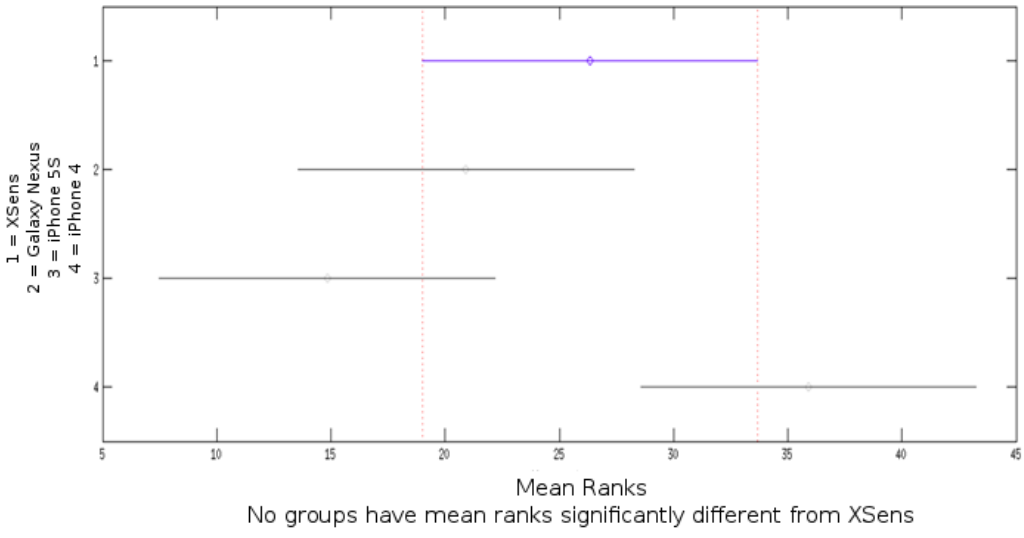
Figure 5. Kruskal–Wallis test result for Xsens roll and pitch Root Mean Square (RMS) compared to Galaxy Nexus, iPhone 5S and iPhone 4 obtained for the static